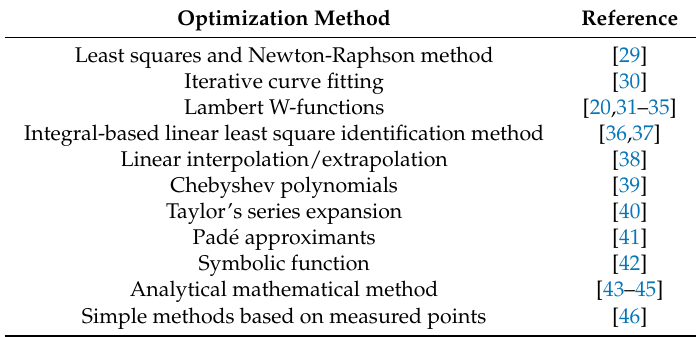
Table 1. A list of analytical and numerical methods employed in the